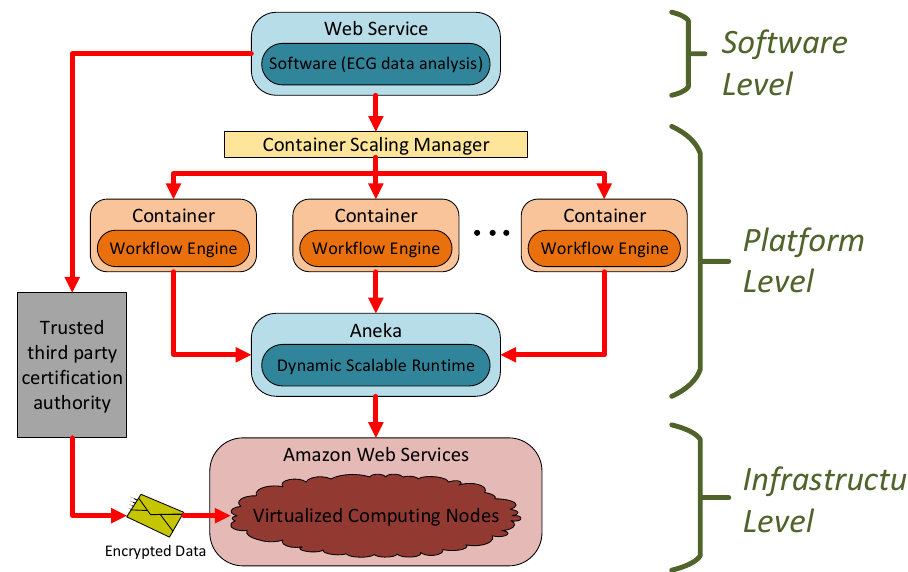
Figure 4. Software architecture of the autonomic system based on